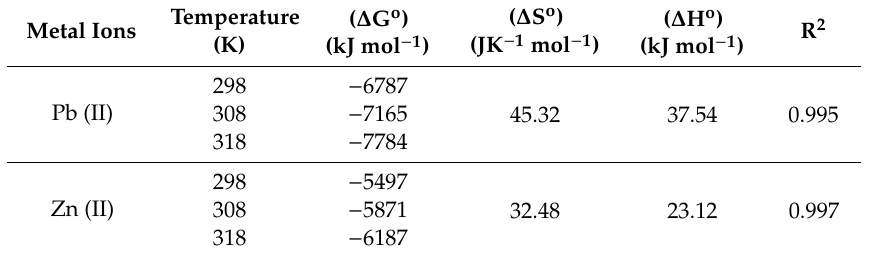
Table 6. Thermodynamics parameters for Pb (II) and Zn (I) ions adsorption on GO adsorbent. Metal